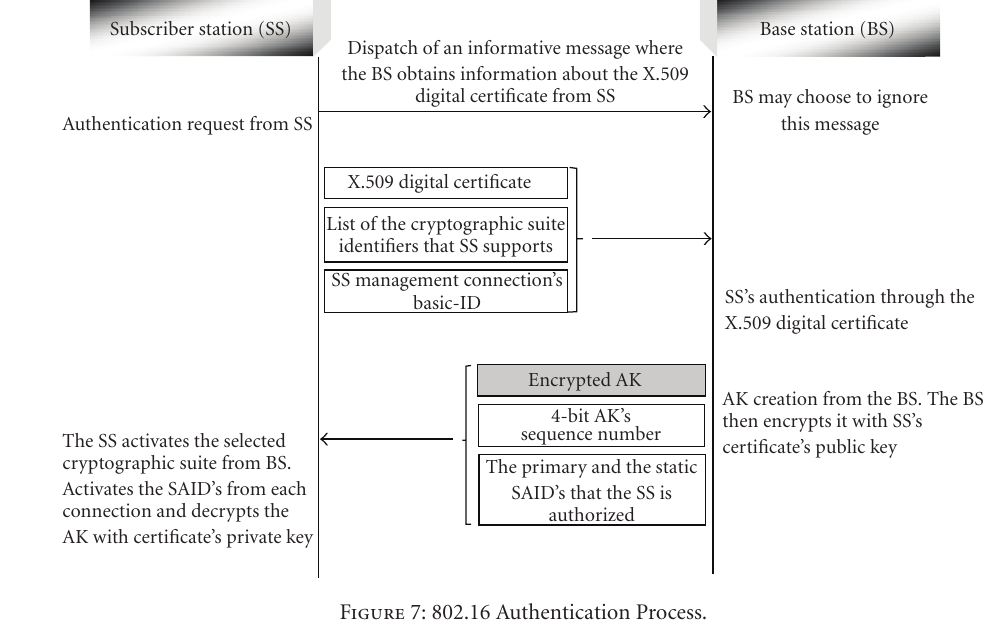
Figure 7: 802.16 Authentication Process.